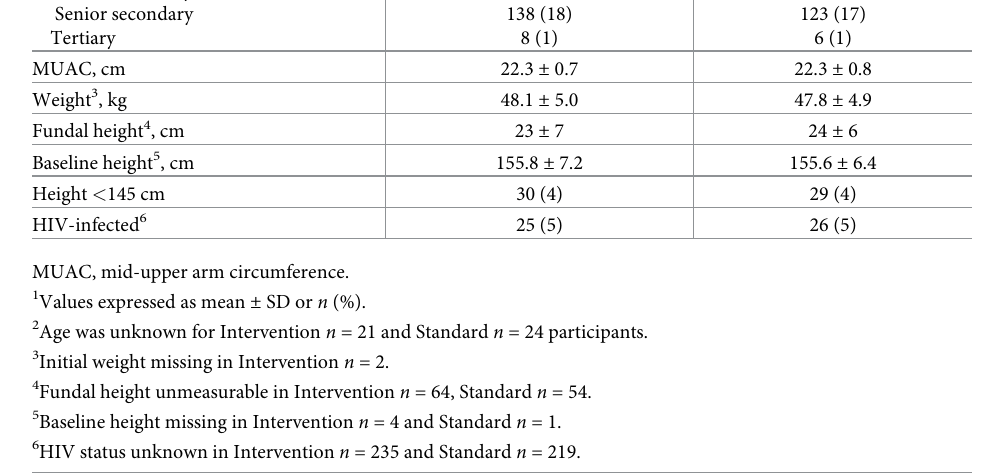
Fig 1. CONSORT flow diagram. “Lost to follow-up” refers to individuals who were not seen at the time point indicated and subsequently never seen again. “Visit data unavailable” refers to individuals who were not seen at the time point indicated but subsequently seen. Deaths are reported as additional deaths between each time point.